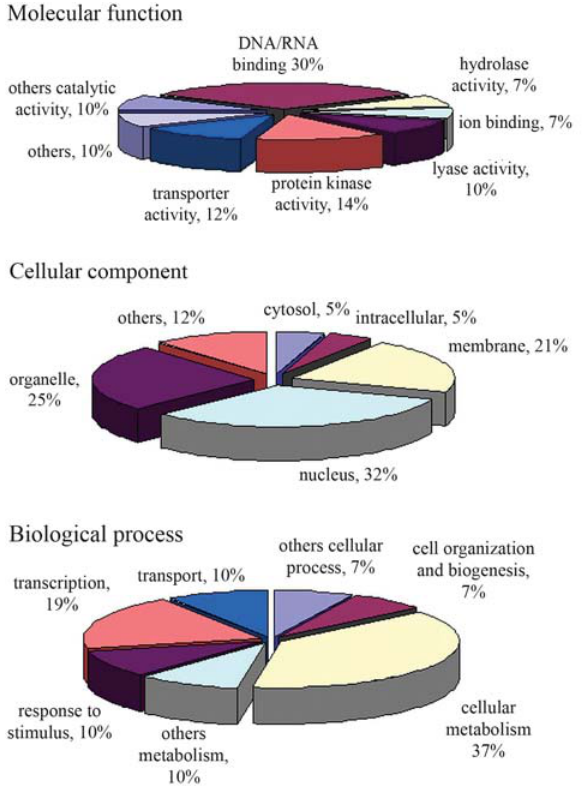
Figure 3 - Citrus EST-SSRs characterization as derived from Gene Ontol- ogy